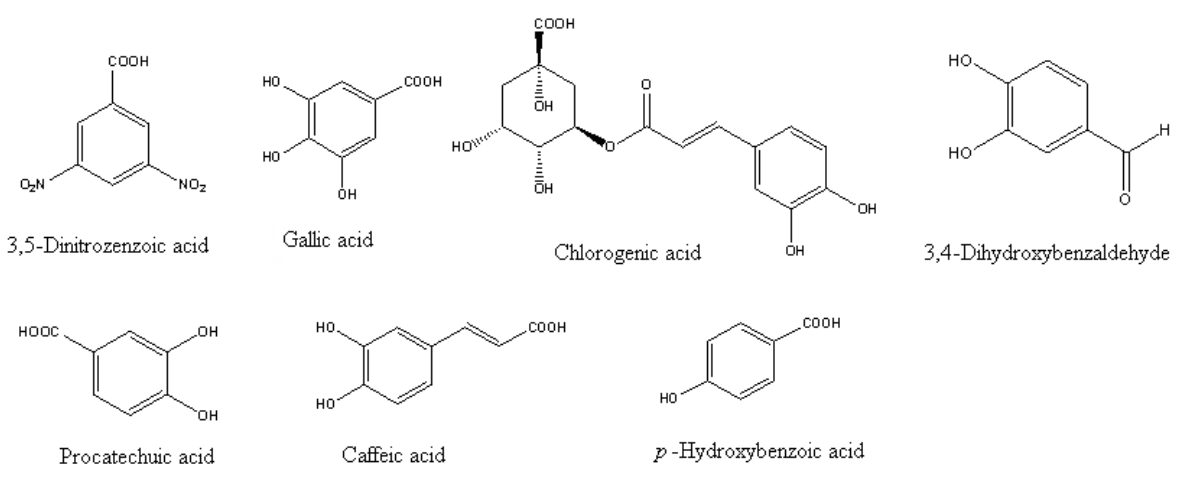
Figure 2. Main phenolic allelochemicals isolated from aqueous extracts of D. regia